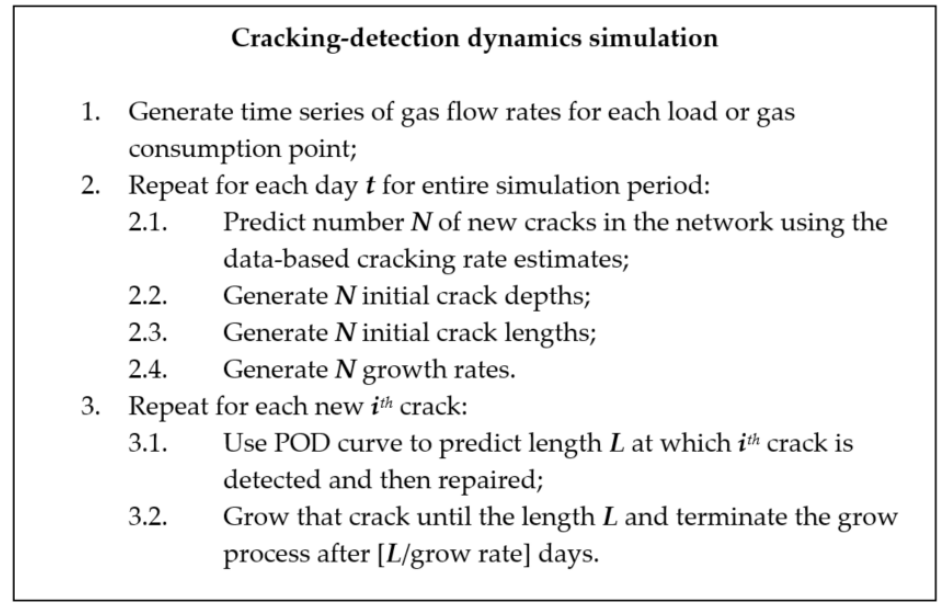
Figure 1. High-level algorithm for crack-detection dynamics in the network simulation.